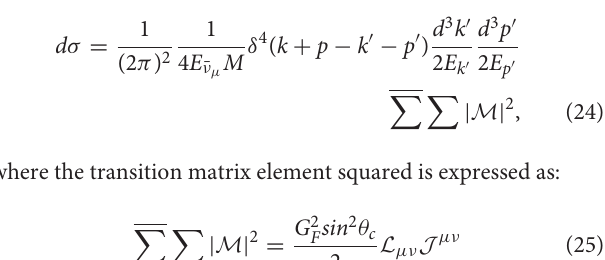
FIGURE 2 | Polarization observables of the hyperon. the orthogonal unit vectors corresponding to the longitudinal, perpendicular, and transverse directions with respect to the momentum of the final